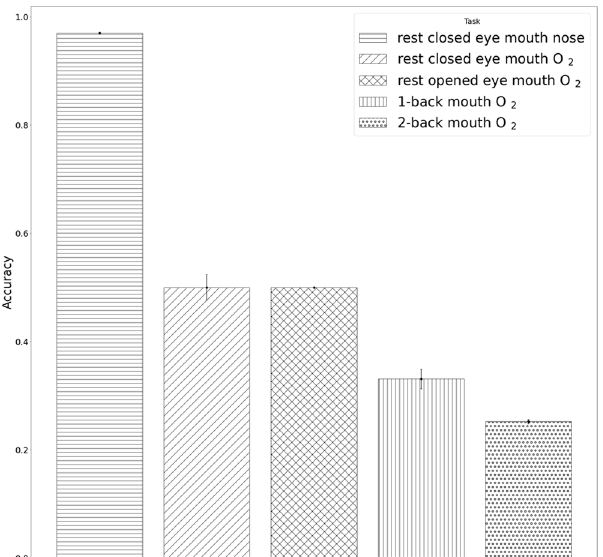
Figure 8. Results of inferences by the linear discriminant analysis random forest (LDARF) classifier. Inference results for electroencephalography (EEG) data of the tasks with three different levels of oxygen demand obtained using 500 LDARF classifier trained with the data recorded during the rest with closed eyes condition.